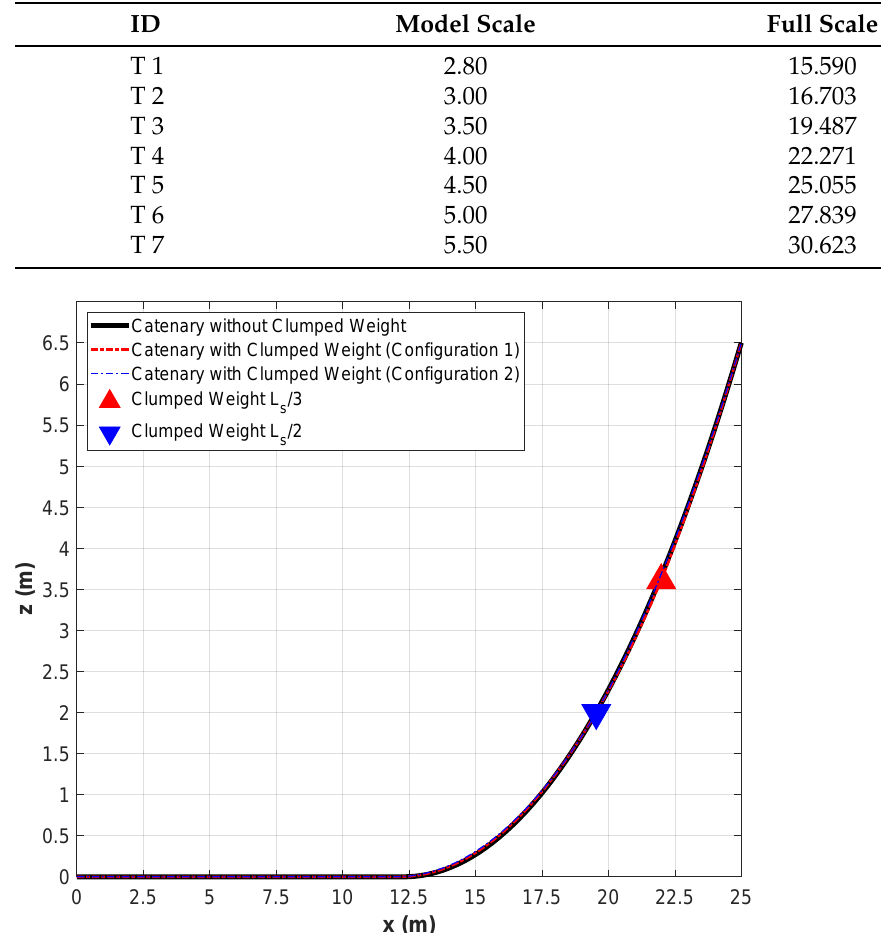
Table 6. Fairlead motions periods in seconds for λ = 1/30.